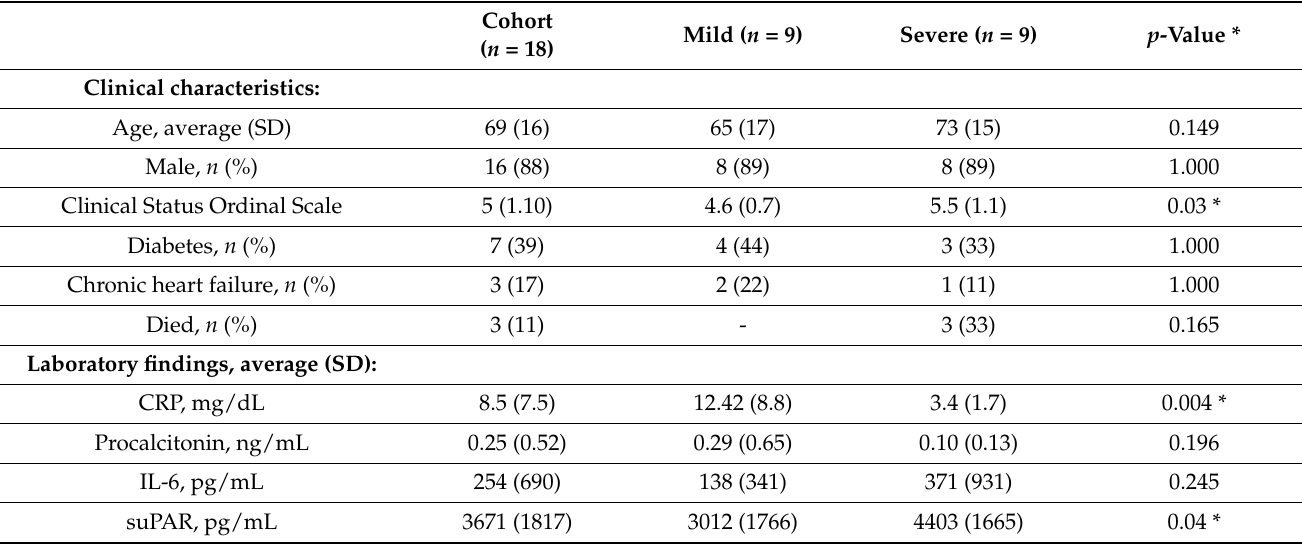
Table 3. Clinical characteristics and laboratory data of hospitalized COVID-19 patients during the Italian first wave.